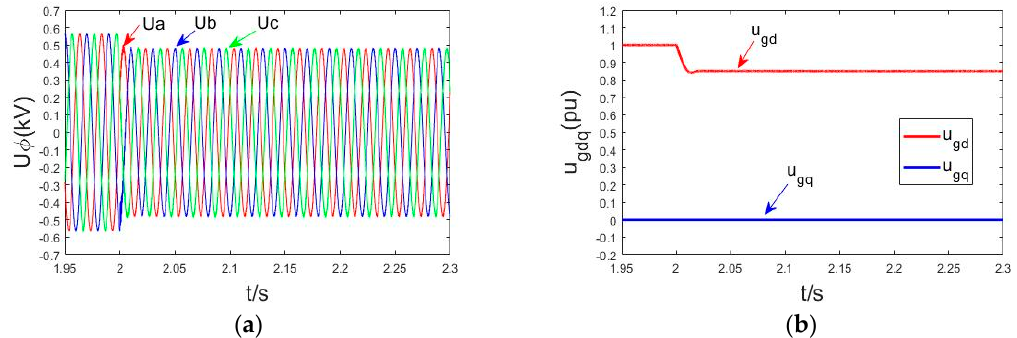
Figure 7. ( a ) Waveforms of three-phase voltage. ( b ) Waveforms of d , q -axis voltage.